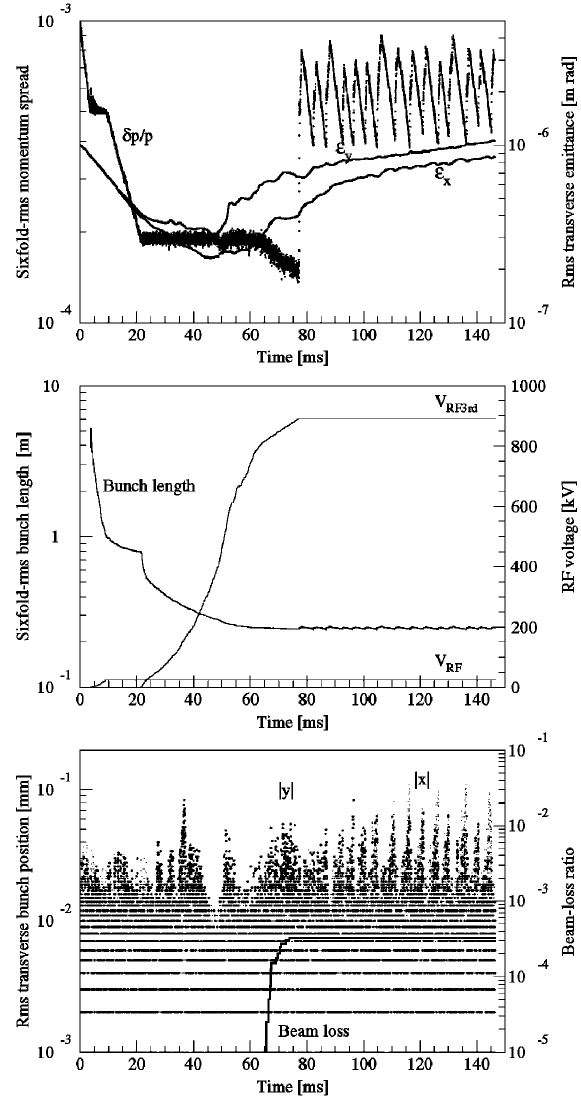
FIG. 8. Time evolution of the beam under the resonance control with a higher 3rd-harmonic rf voltage